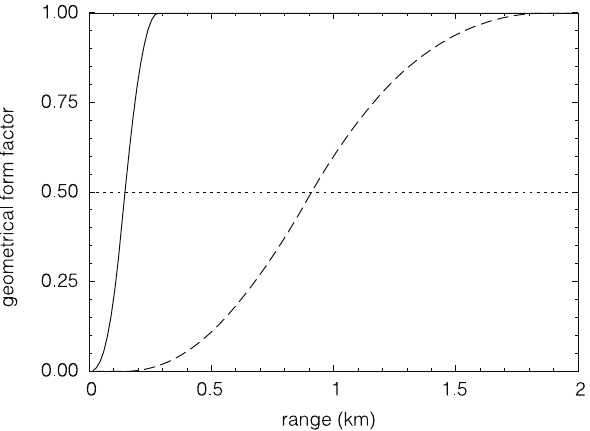
Fig. 1. Geometrical form factors for the two receivers: small telescope (solid line); large telescope (dashed